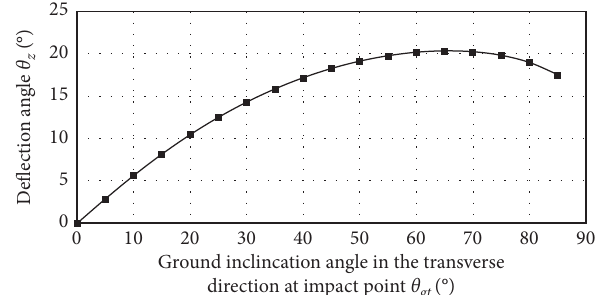
Figure 3: Deflection angle varied with ground inclination angle in the transverse direction at impact